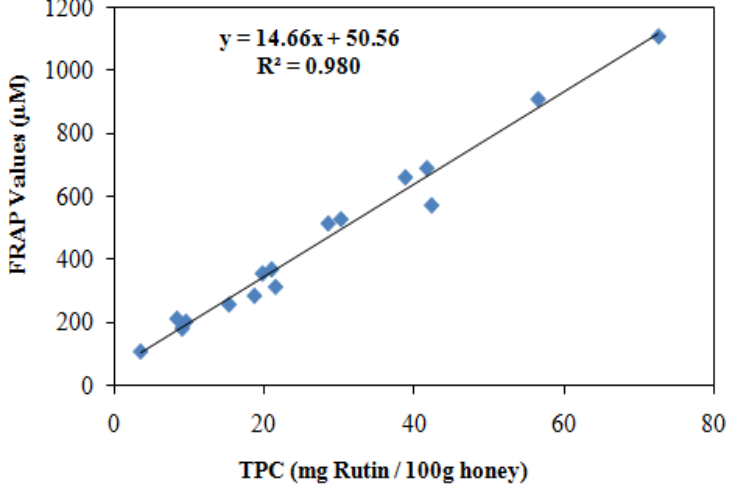
Figure 1. Correlation between the ferric reducing antioxidant power (FRAP value) of combined (Gelam and Nenas) honeys and the total phenolic contents (TPC) to obtain the r = 0.9899.